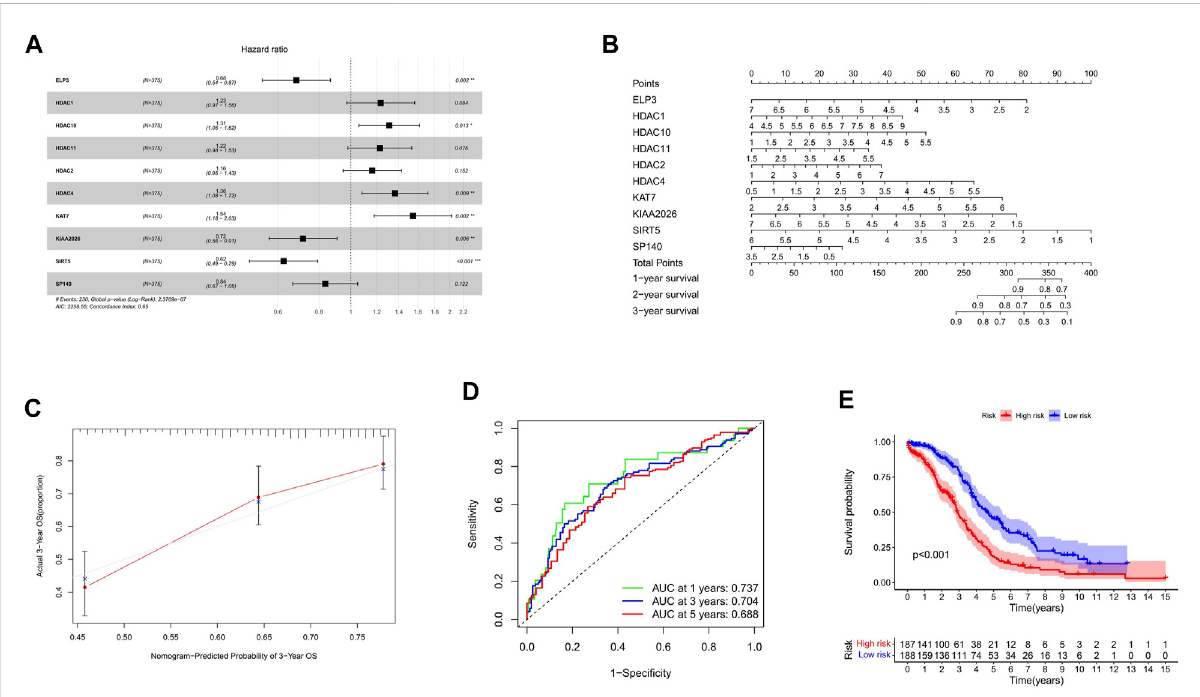
FIGURE 3 Construction of HAM signature by LASSO regression. (A,B) Prediction of immune cell proportion in TCGA and GTEx samples. (C) Calibration curve of 3-year OS. (D) Time-dependent ROC curves predicted 1-, 3-, and 5-year prognostic performance in the training cohort. (E) Kaplan – Meier curves to compare the OS of high-risk and low-risk groups in a training